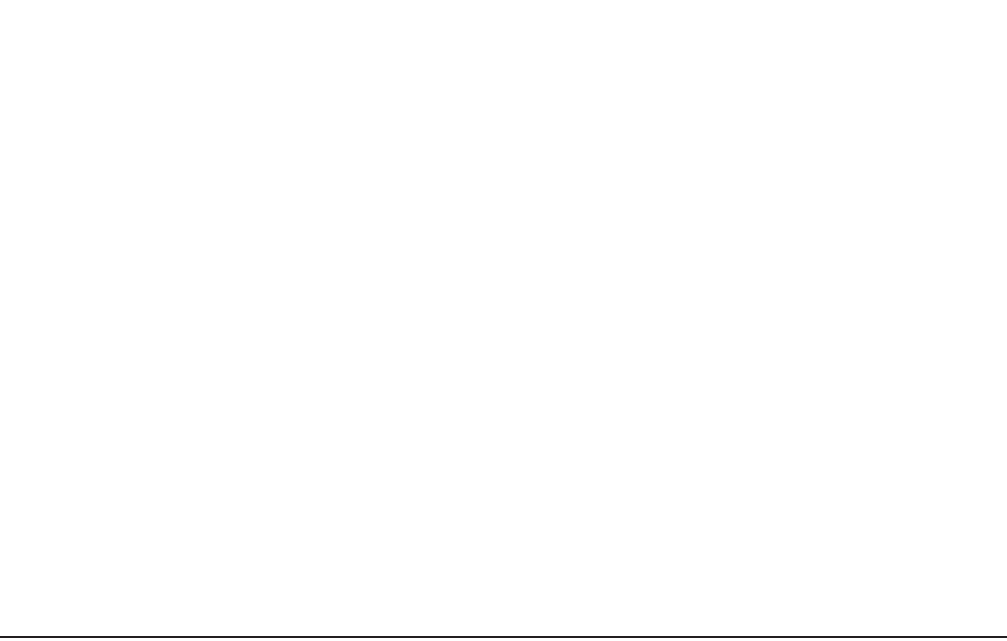
FIGURE A1 | Intradermal formalin does not produce a significant contralateralhyper-reactivity inuntrainedsubjectswithcompleteSCI. (A) Time-course of tactile response with repeated von Frey testing on the plantar surface of ipsilateral hindpaw after intradermal formalin injection.